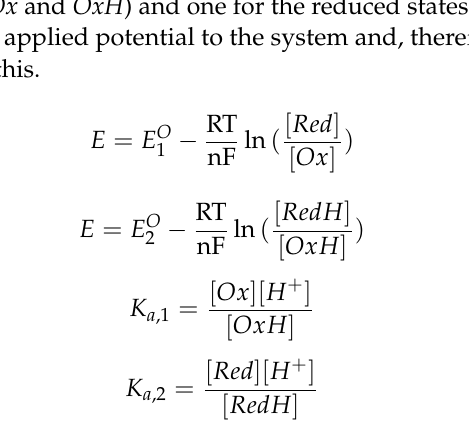
Scheme 1. Scheme showing the reactions in a simple proton coupled electron transfer (PCET) process. The oxidised and deprotonated species Ox can be reduced to Red with a redox potential of E O The oxidised and protonated species OxH can be reduced to give RedH with a redox potential of E O OxH can be deprotonated to Ox with an acid dissociation constant K a, 1 . RedH can be deprotonated to give Red with an acid dissociation constant K a, 2